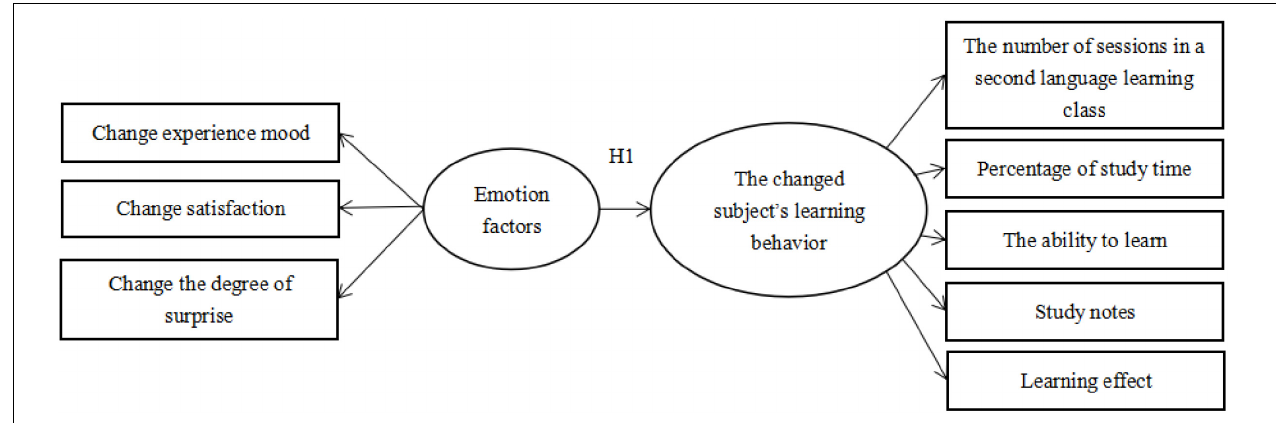
FIGURE 2 | The conceptual model of affective factors influencing the learning behavior of the changed students.